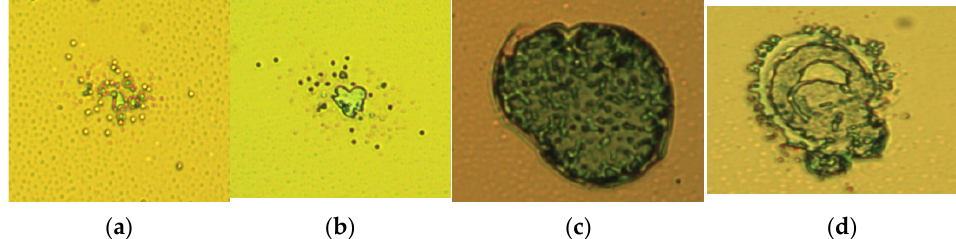
Figure 5. Damage morphology of multilayer film irradiated by picosecond laser for different fluences. Laser fluences are 2.11 J·cm − 2 ( a ), 2.19 J·cm − 2 ( b ), 2.40 J·cm − 2 ( c ), and 2.71 J·cm − 2 ( d ).